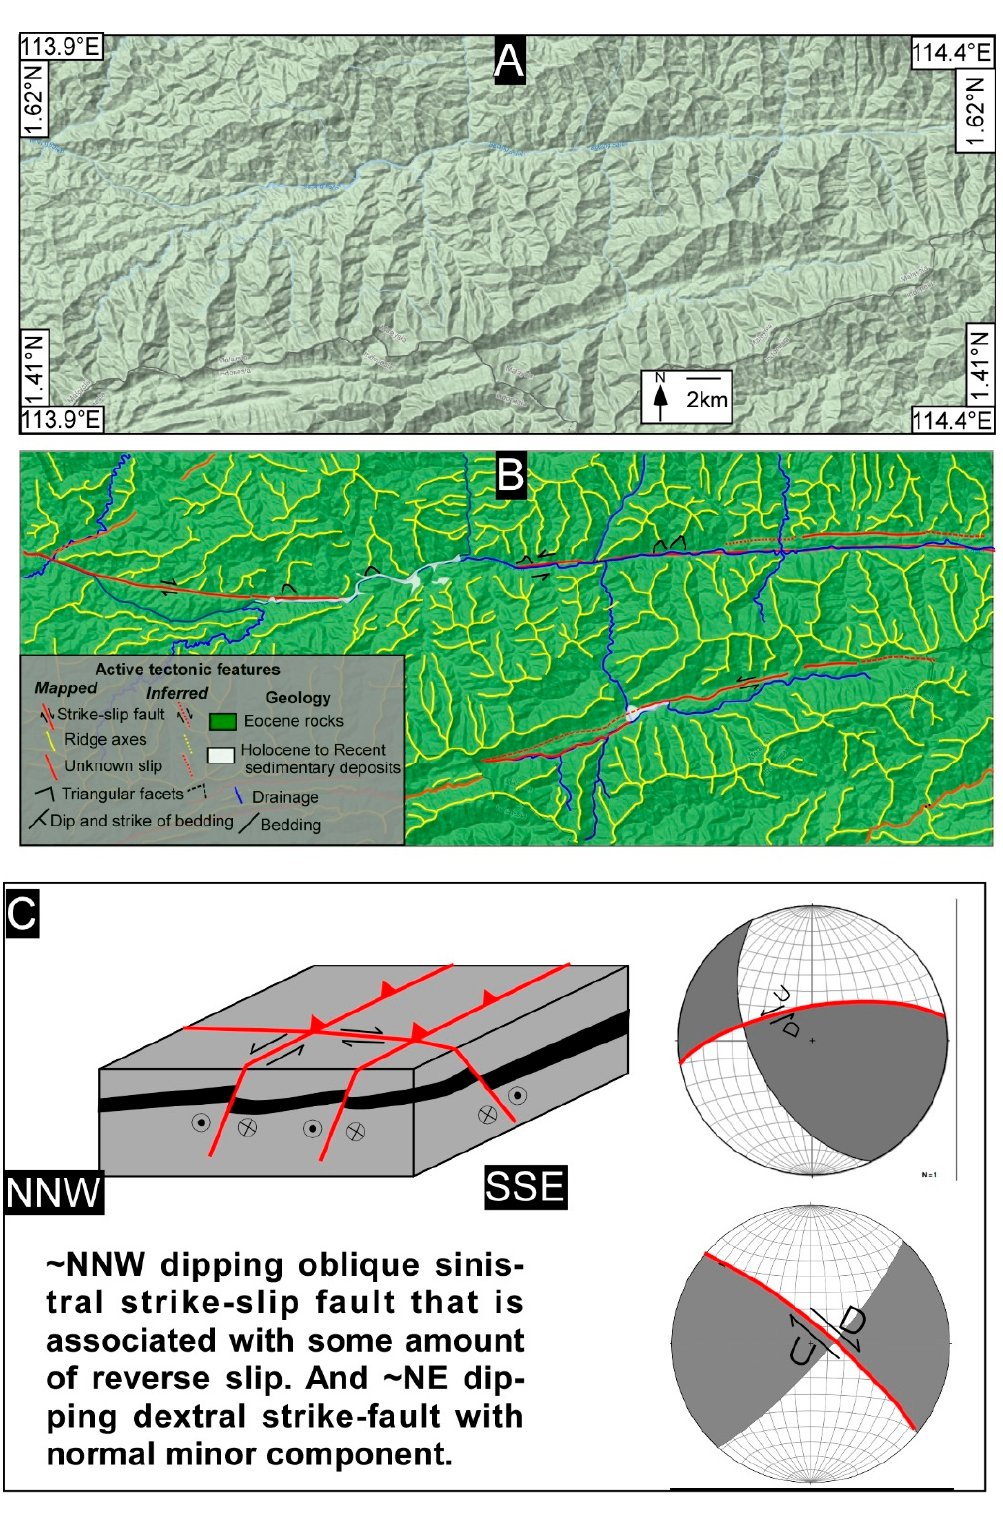
Figure 9. ( A ) Un-interpreted Google satellite image. ( B ) Evidence of clearly visible strike-slip faulting with two prominent traces that run oblique to each other. The topographic breaks, triangular facets, and drainage deflections are clearly traceable. ( C ) Cartoon shows the possible nature of faulting where dextral-strike slip faults have a component of normal dip-slip and sinistral faults have a component of reverse slip. The expected fault plane solution is also shown.